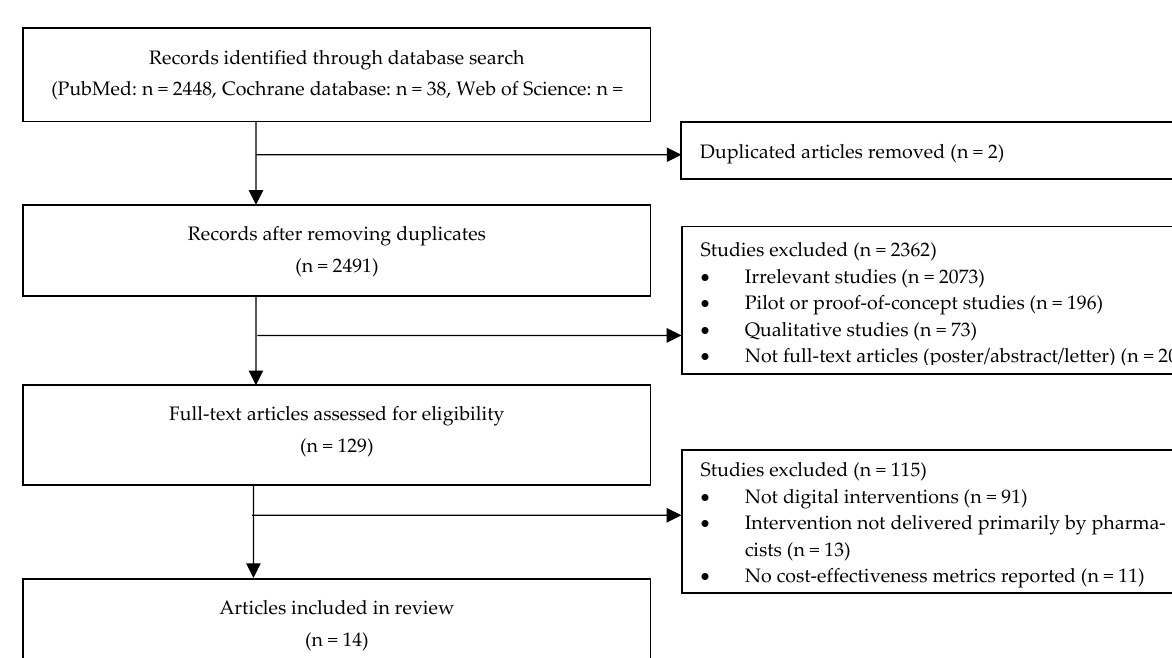
Table 1. The Quality of Health Economics Studies (QHES) instrument.